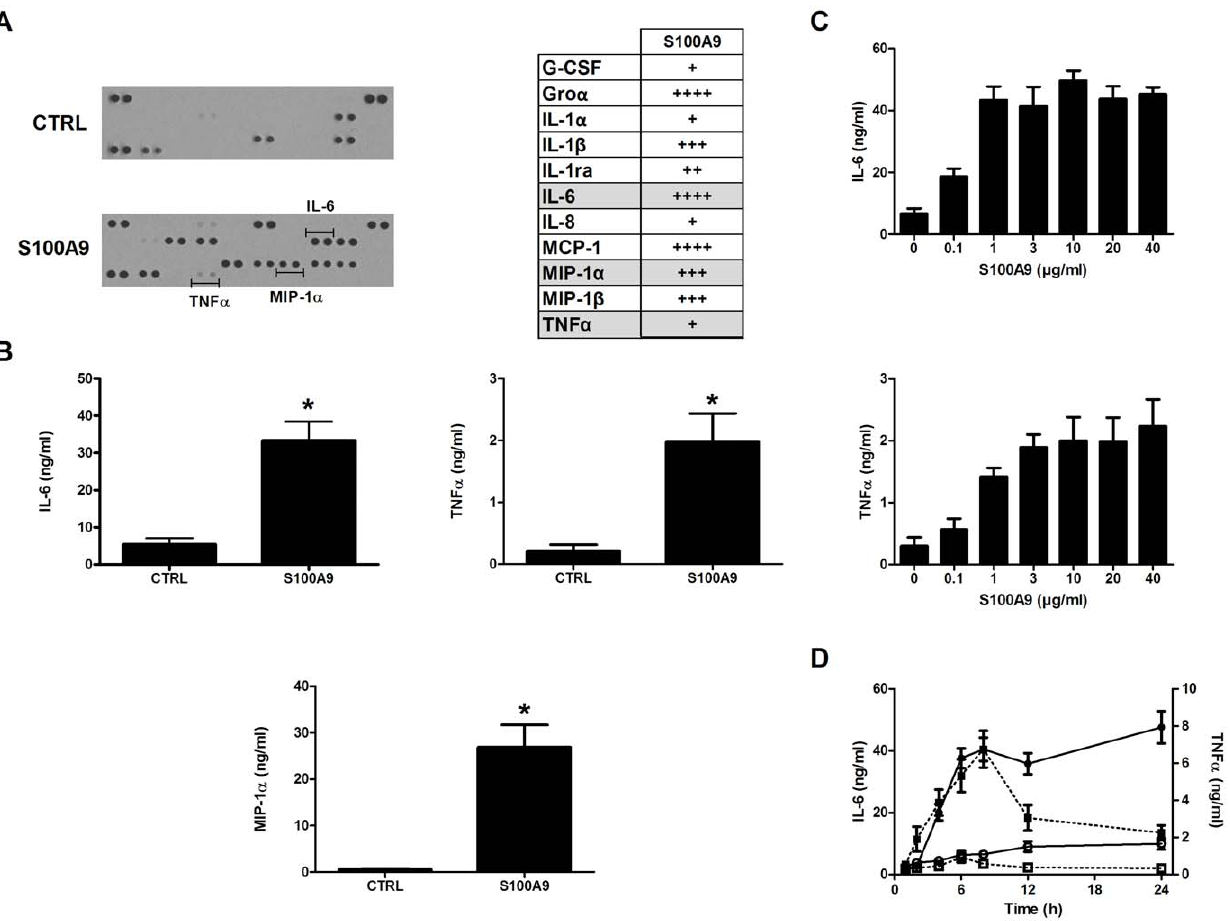
Figure 9. S100A9 induces the secretion of cytokines by monocytes. Cells (1 6 10 6 cells/ml) were incubated with S100A9 (10 m g/ml) for 24 h. Supernatants were harvested and cytokines were measured by (A) cytokine arrays or (B) ELISA. CTRL: unstimulated cells. Values are the mean 6 SEM of 5 different experiments. *p , 0.05, t test. (C) Monocytes were stimulated with different concentrations of S100A9 (0.1–40 m g/ml) and IL-6 or TNF- a concentrations were measured in the supernatant. (D) Monocytes were incubated with 10 m g/ml of S100A9 and IL-6 or TNF- a concentrations were assessed as a function of time. Solid line: IL-6 dosage (open circles: unstimulated cells, solid circles: S100A9 stimulated cells), dotted line: TNF- a (white squares: unstimulated cells, solid squares: S100A9 stimulated cells).